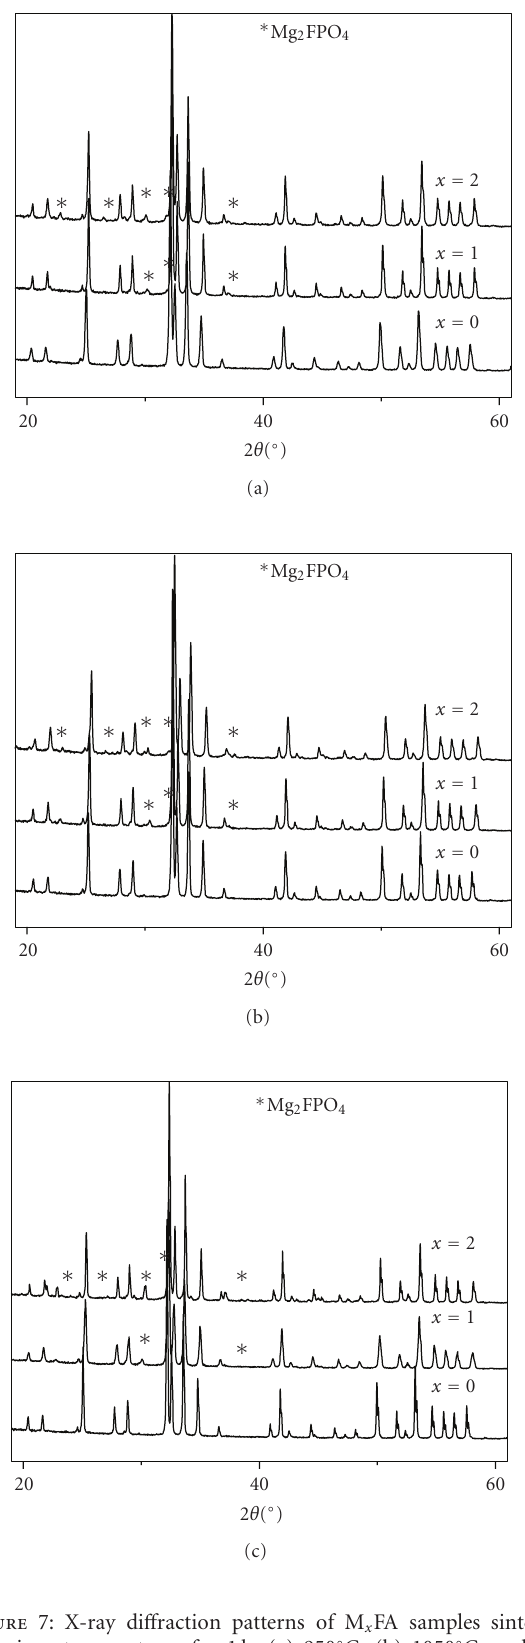
Figure 7: X-ray di ff raction patterns of M x FA samples sintered at various temperatures for 1h: (a) 950 ◦ C, (b) 1050 ◦ C, and (c) 1200 ◦ C.